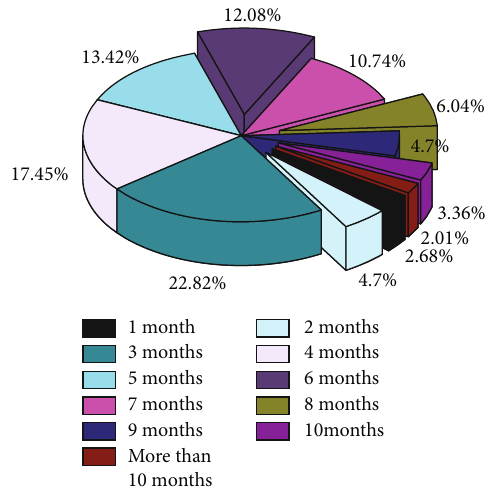
Figure 5: The duration of the desire of the subject ’ s desire for